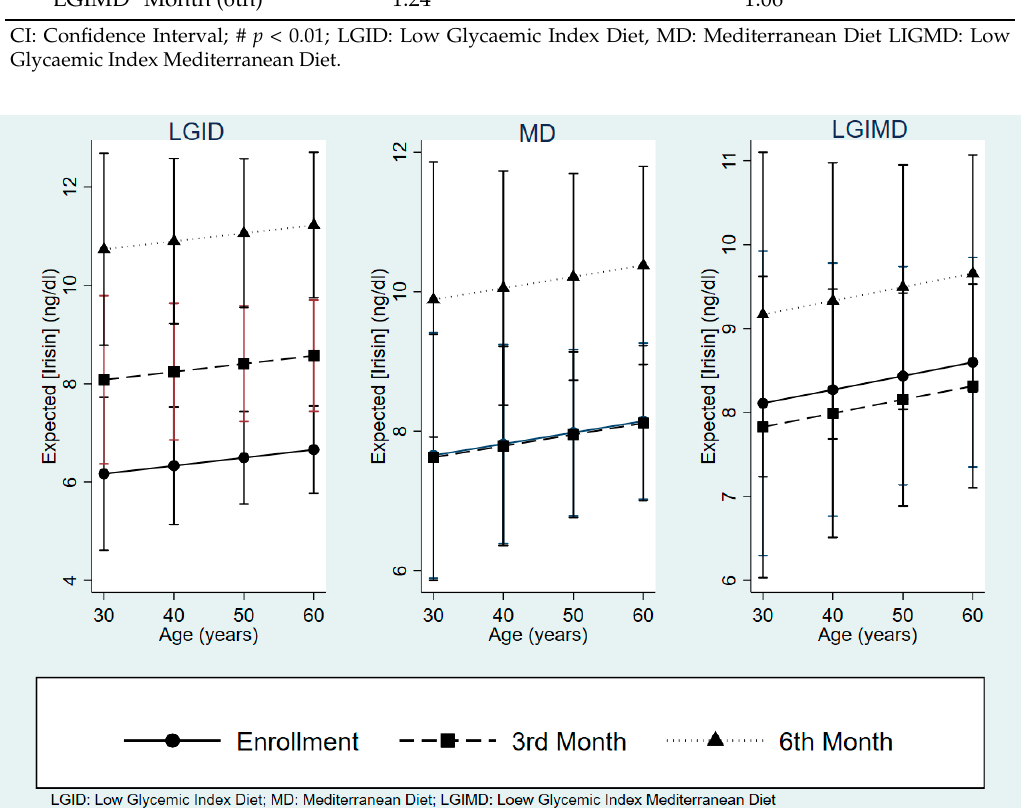
Figure 2. Expected irisin Concentrations by Diet, Age and Time. Medidiet Trial, Castellana Grotte (Italy). Generalized Estimation Equation Analysis.